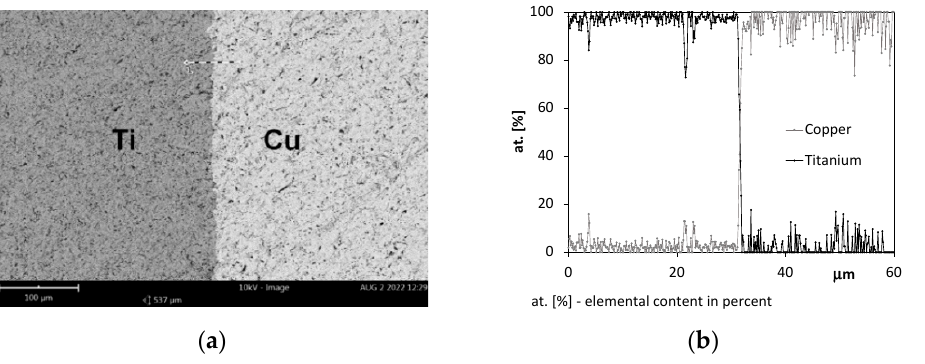
Figure 12. Contact zone of titanium and copper in the bimetal before the annealing process ( T = 20 °C): ( a ) SEM photo, ×500, ( b ) linear analysis of Ti and Cu distribution in the contact zone. Figures 13 and 14 show the characteristic zones of the joining of Ti and Cu layers.